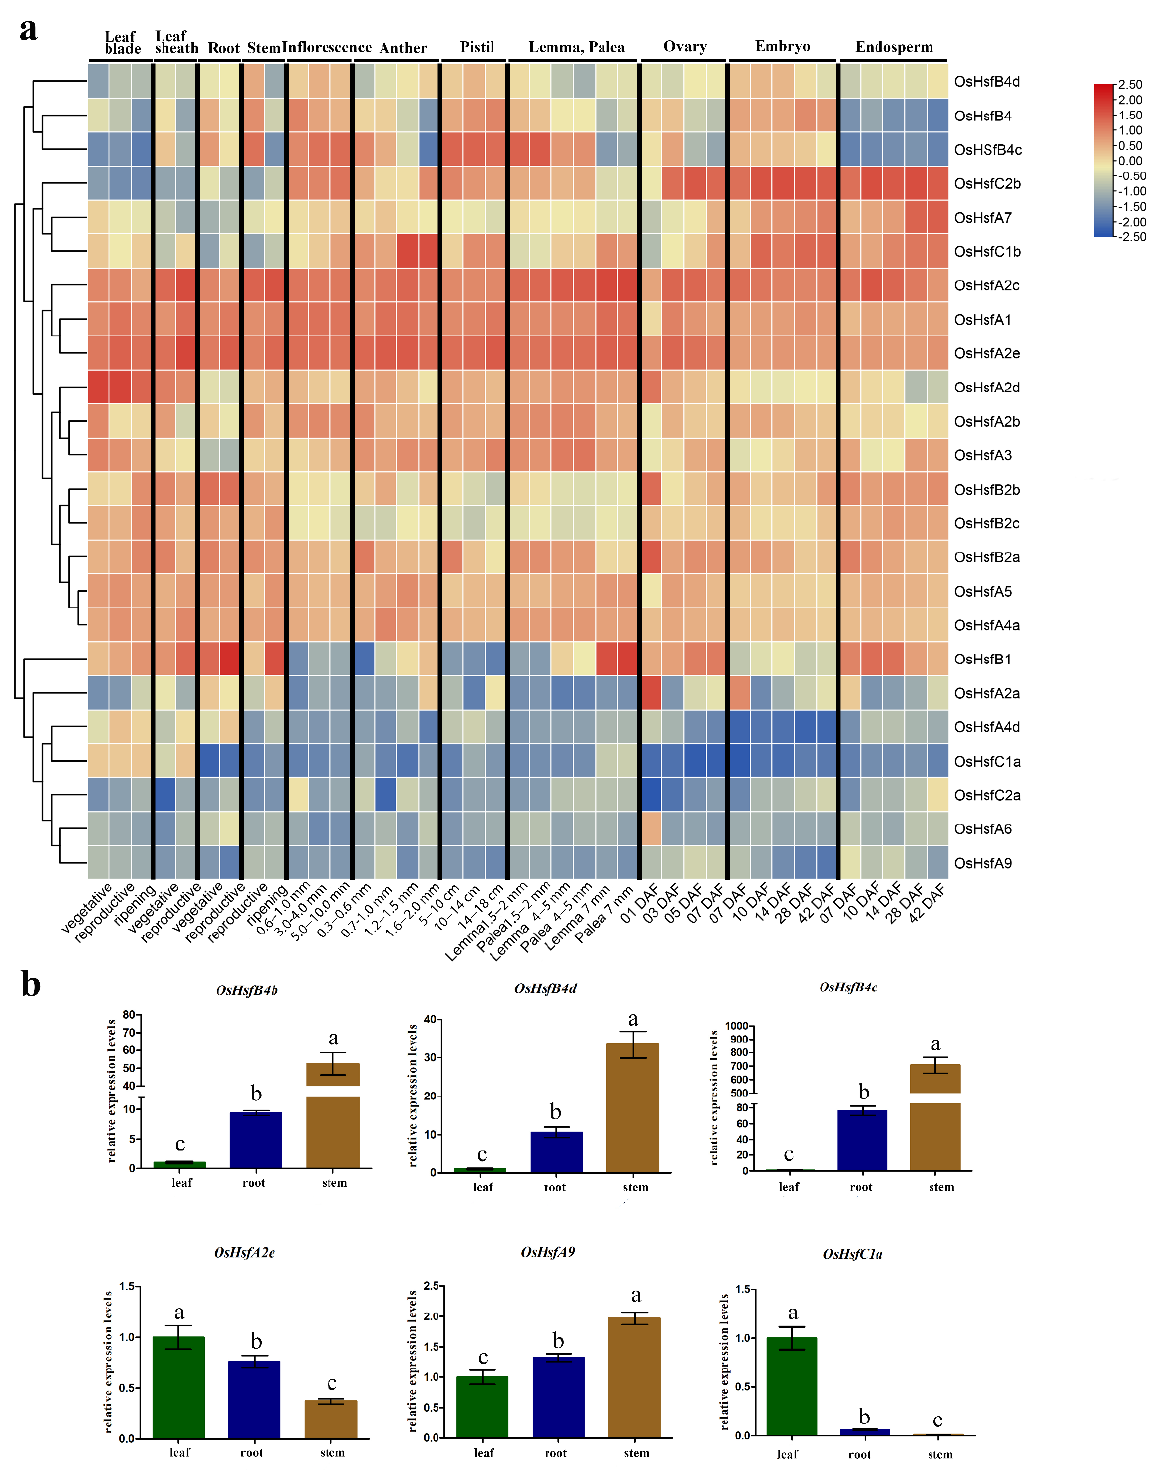
Figure 4. Expression profiles of the OsHsf genes. ( a ) Hierarchical clustering of expression profiles of OsHsf genes in 48 samples including developmental stages of different tissues. DAF: day after fertilization; ( b ) Expression analysis of some OsHsf genes in different tissues (leaf, root, and stem) by qRT-PCR. Data were normalized to OsActin1 and OsActin2 . Different letters indicate significant differences at p < 0.05 according to one-way ANOVA and post-hoc Tukey’s test.